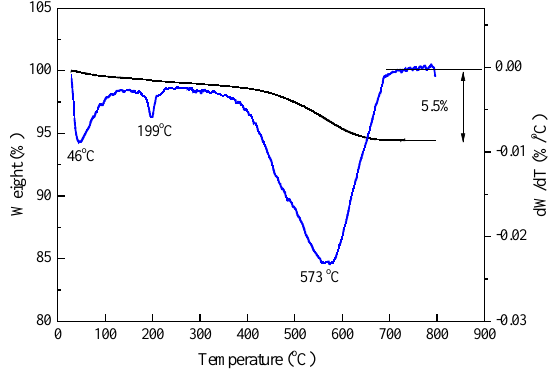
Figure 5. TGA profiles of the spent 1.0 wt. % Pt/Z-57 catalysts.